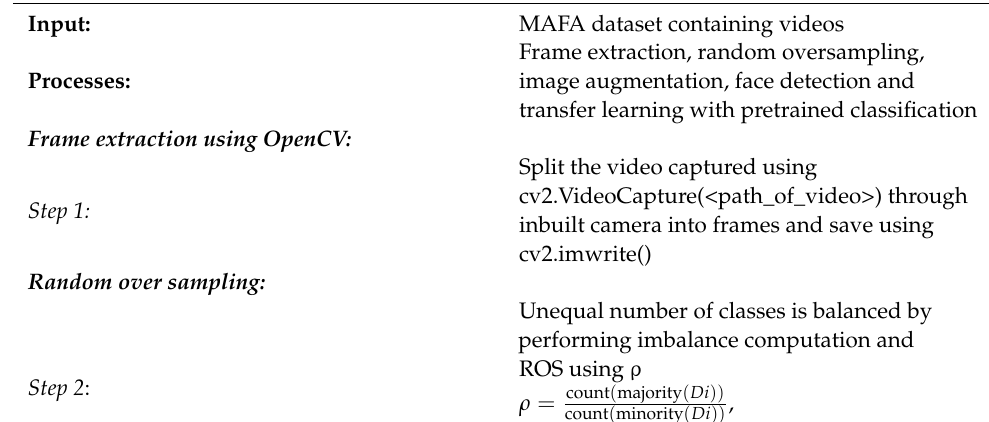
Algorithm 1. Training